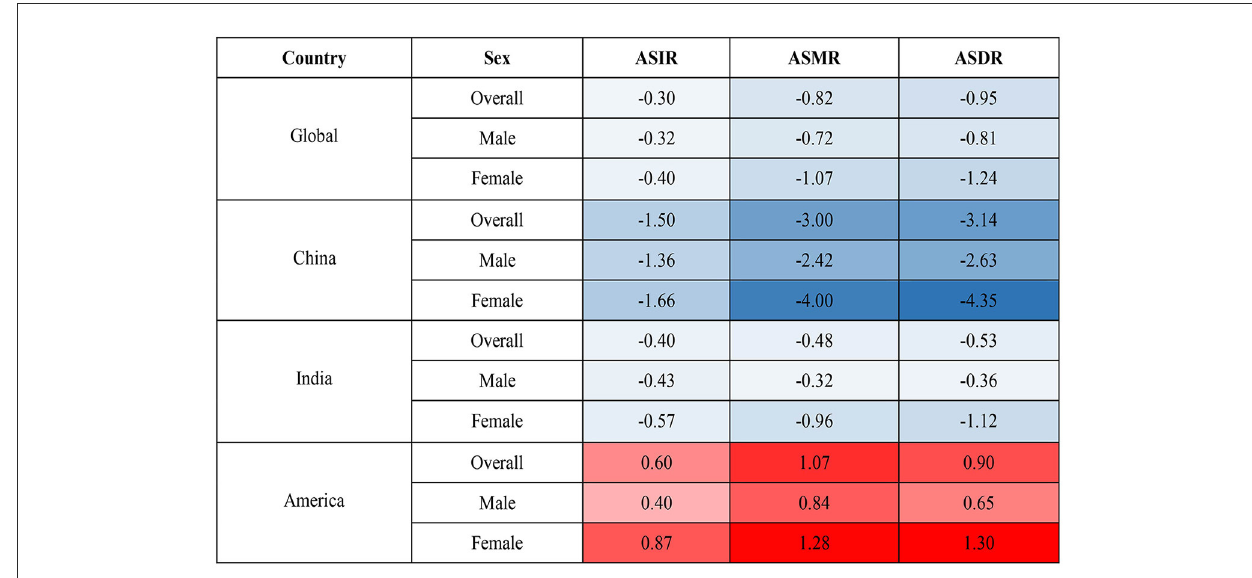
FIGURE1 AAPC in ASIR, ASMR, and ASDR from 1990 to 2019. AAPC, average annual percent change; ASIR, age-standardized incidence rate; ASMR, age-standardized mortality rate; ASDR, age-standardized DALY rate.